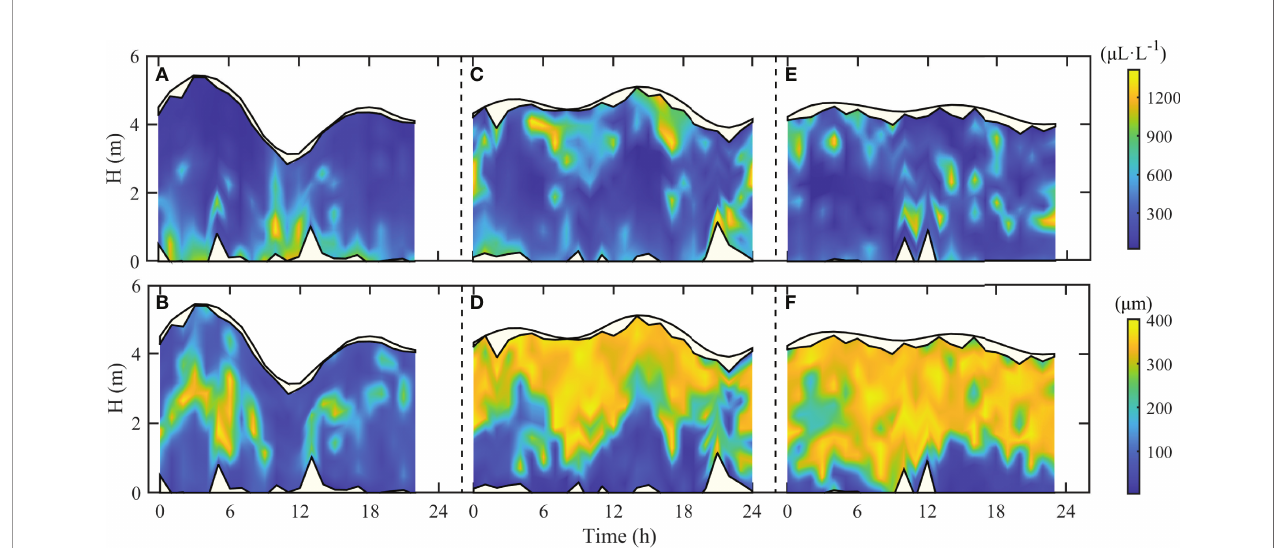
FIGURE 6 | Vertical and temporal variation of (A, C, E) fl oc volumetric concentration ( m L·L -1 ) and (B, D, F) median fl oc size ( m m). ( A – B, C – D, E – F , represent the spring, middle, and neap tides, respectively, and the white shadowed area represents the area for which no useful LISST data could be derived, due to high SSC